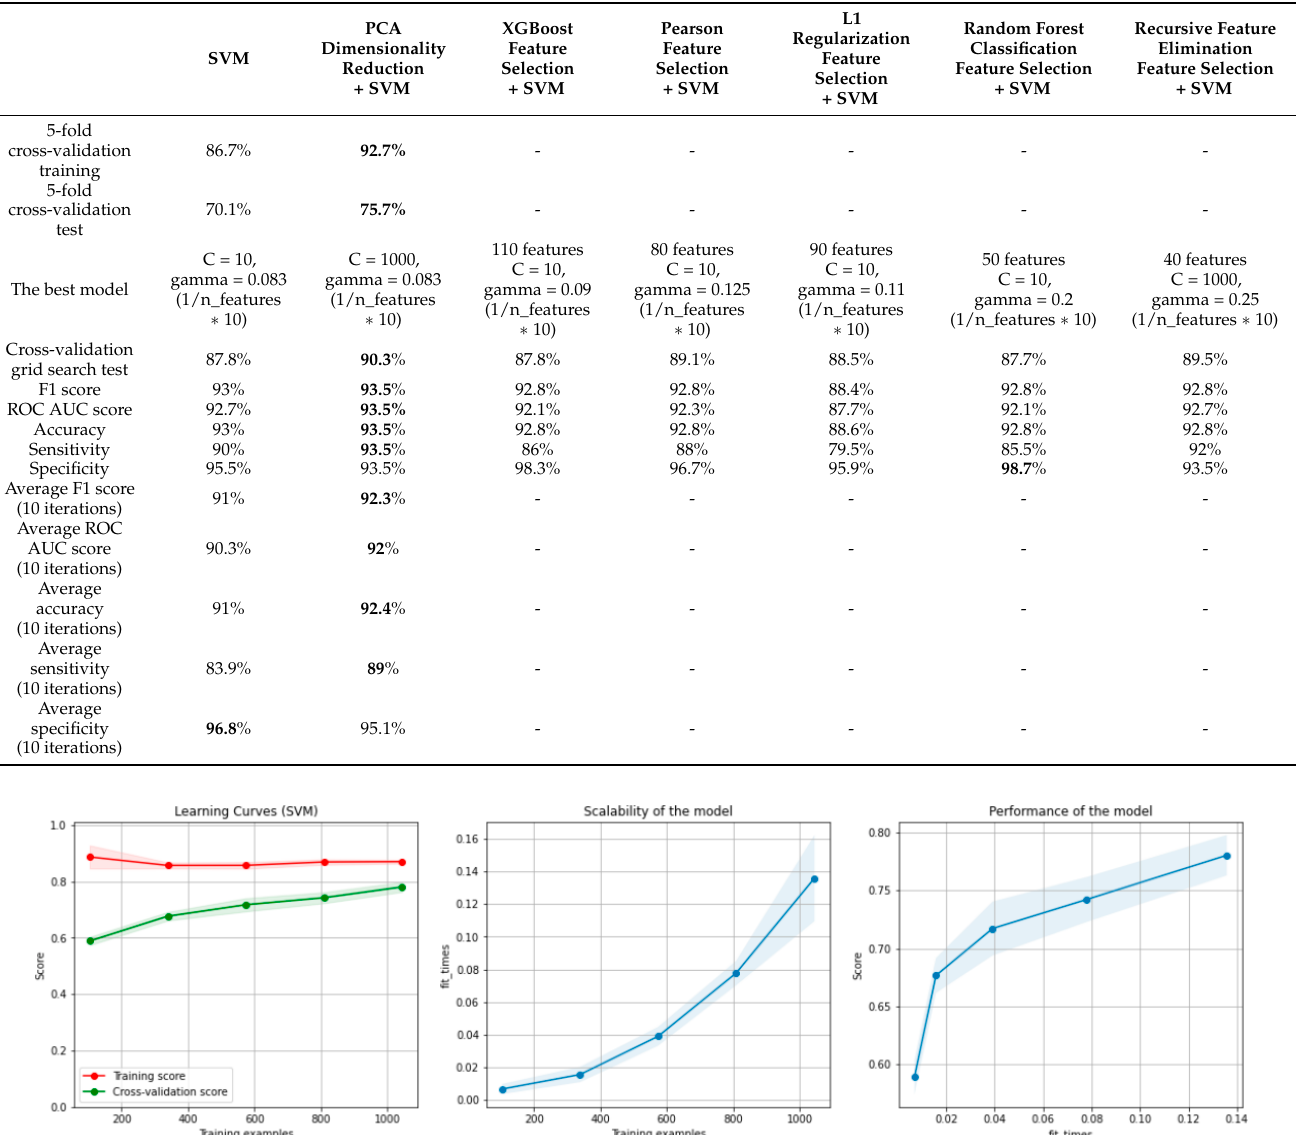
Table 2. Results of the DT algorithms applied on the non-overlapping dataset.